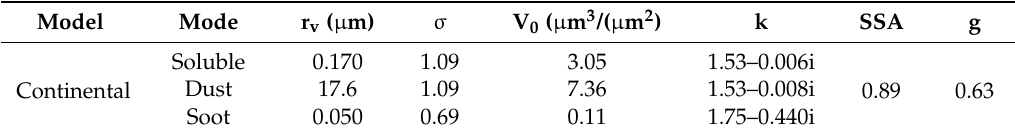
Table 4. Optical properties of continental model used in AOD retrieval. Model